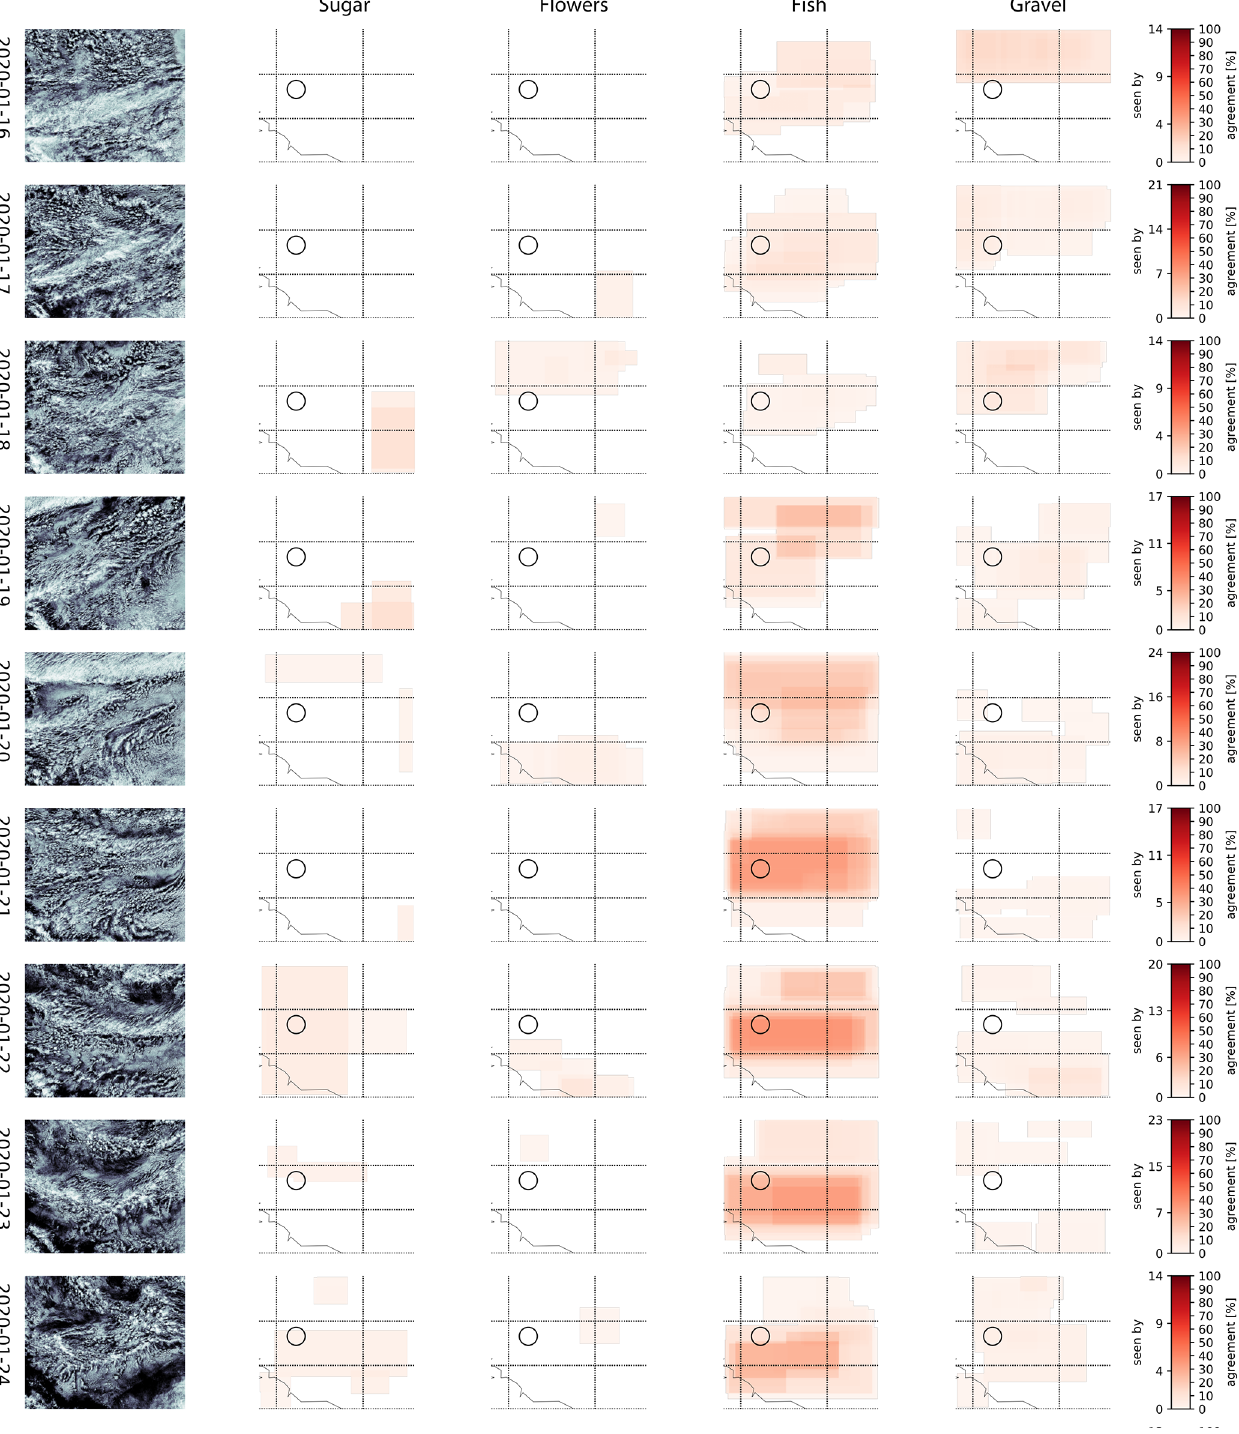
https://doi.org/10.5194/essd-14-1233-2022 Earth Syst. Sci. Data, 14, 1233–1256,